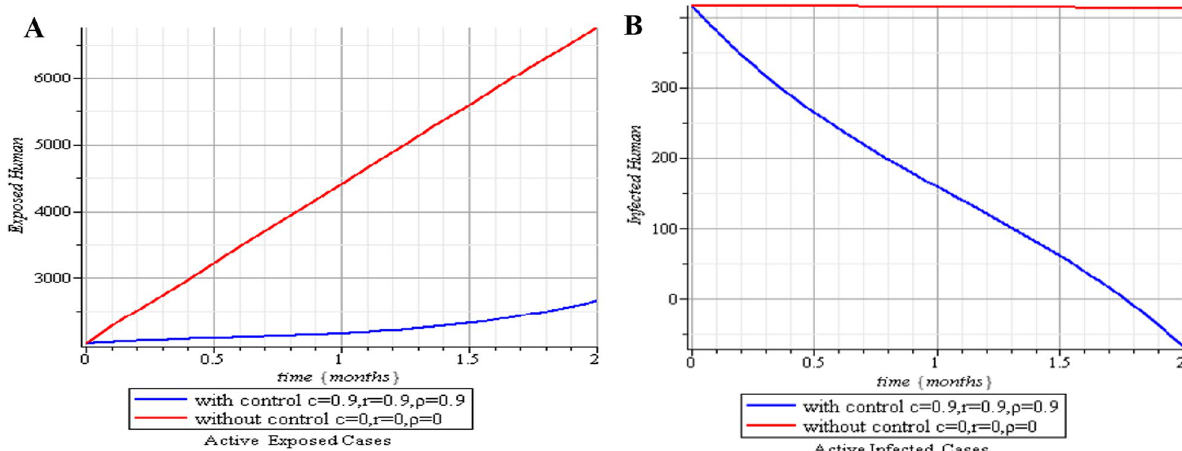
Fig. 12 Exposed and infected cases with control and without